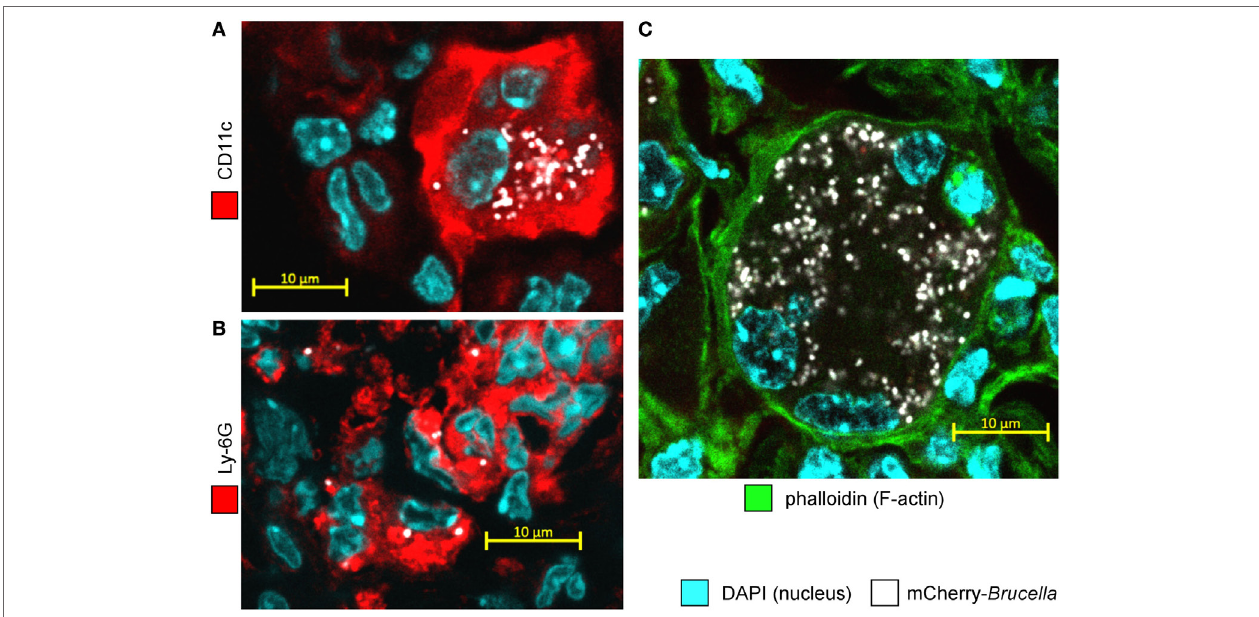
FigUre 4 | Alveolar macrophages and neutrophils are both infected with Brucella melitensis in the lungs of Alt- sensitized BALB/c mice. Wild-type BALB/c mice received repeated i.n. administration of Alt before i.n. infection with 2 × 10 4 CFU of mCherry- B. melitensis . The mice were sacrificed at 12 days post infection. The lungs were harvested, fixed, and frozen sections were immunostained and examined by confocal microscopy. (a,B) Representative confocal images of single optical sections of mCherry- Br infected CD11c + cells and Ly-6G + cells stained with DAPI from Alt sensitized wild-type BALB/c mice. (c) Representative infected multinucleated giant cells stained with DAPI and phalloidin. The panels are color-coded for DAPI, phalloidin, the cell surface antigen examined or mCherry- Brucella . Scale bars = 10 µm, as